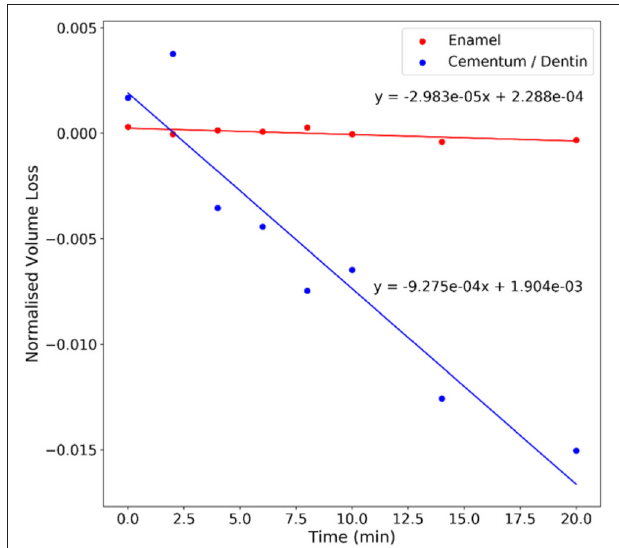
FIGURE 4 | Plot of the average normalized changes in volume for the enamel and cementum/dentin vs. the cumulative brushing time (in minutes).